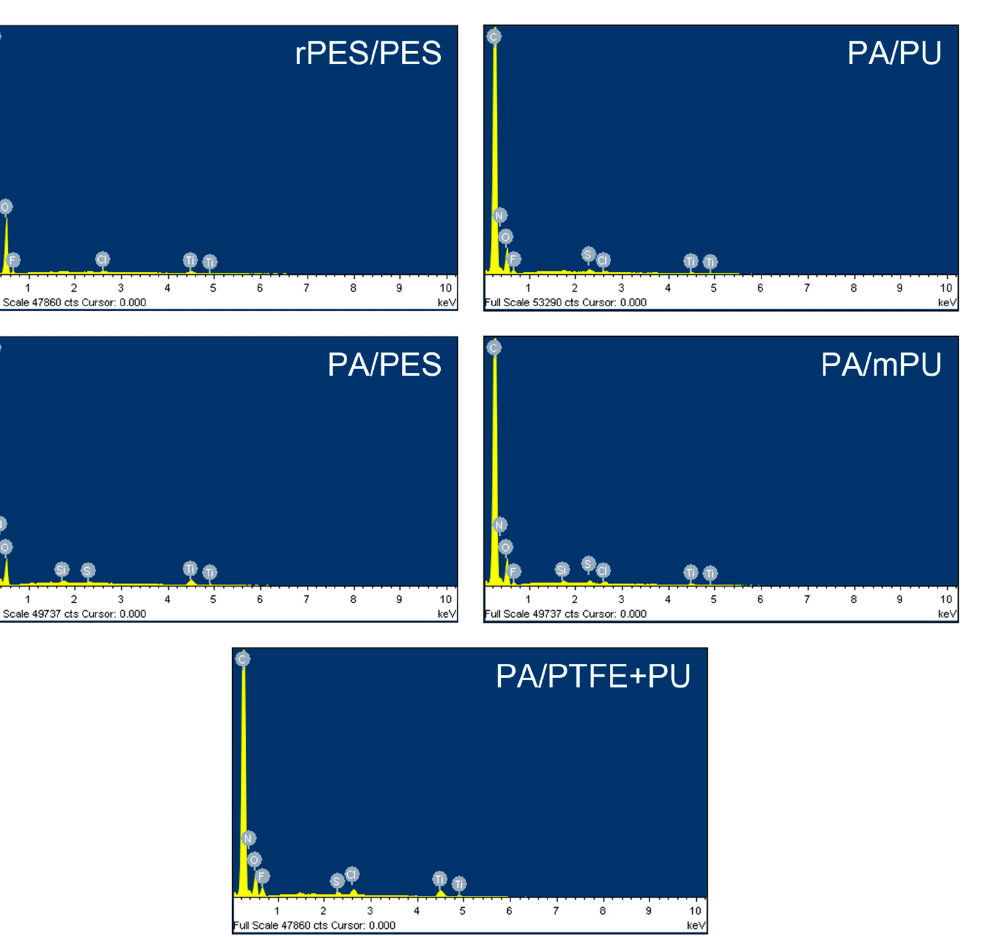
Figure 4. The sample EDS spectra of the fabric surfaces.